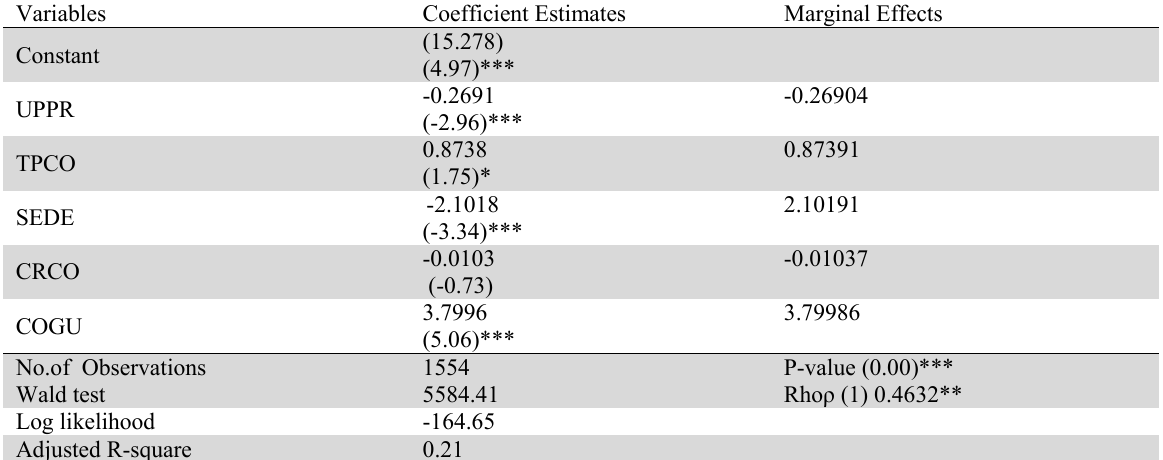
Results from Random Effects Binary Logit for the Unbalanced Panel of the leasing companies, the Panel Period 2005-2010